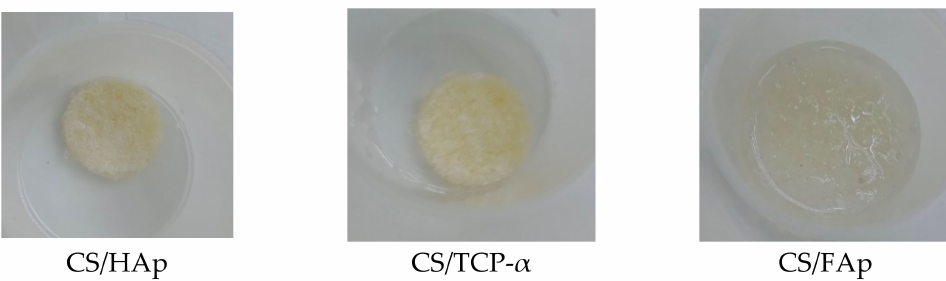
Figure 8. The scaffolds’ physical condition following submerging in SBF for two weeks, where the swelling of chitosan was observed the most in CS/FAp.